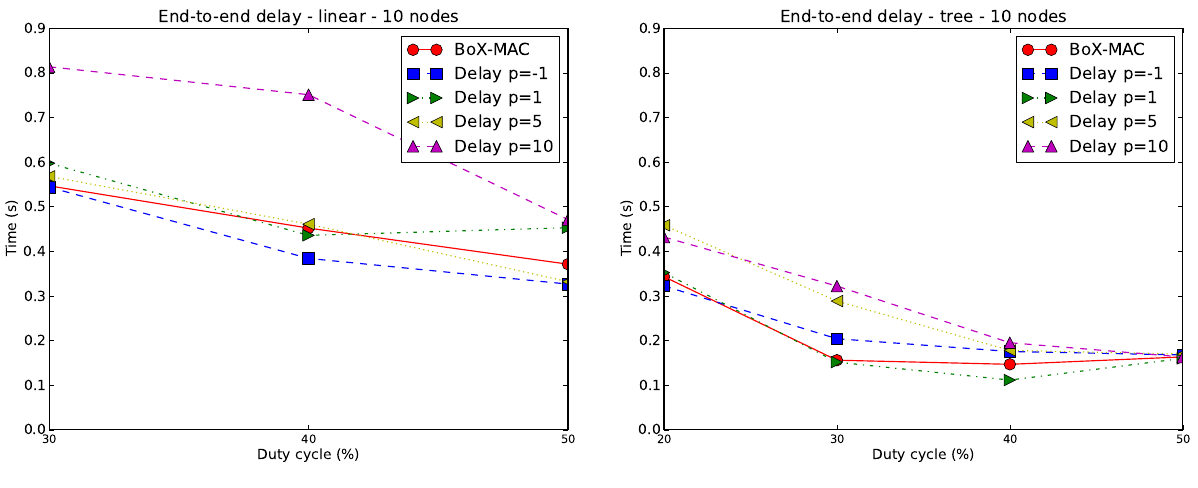
Figure 14. End-to-end delay for 10-node linear and 10-node tree